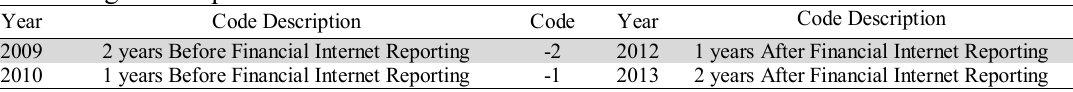
The Coding of Comparison Years